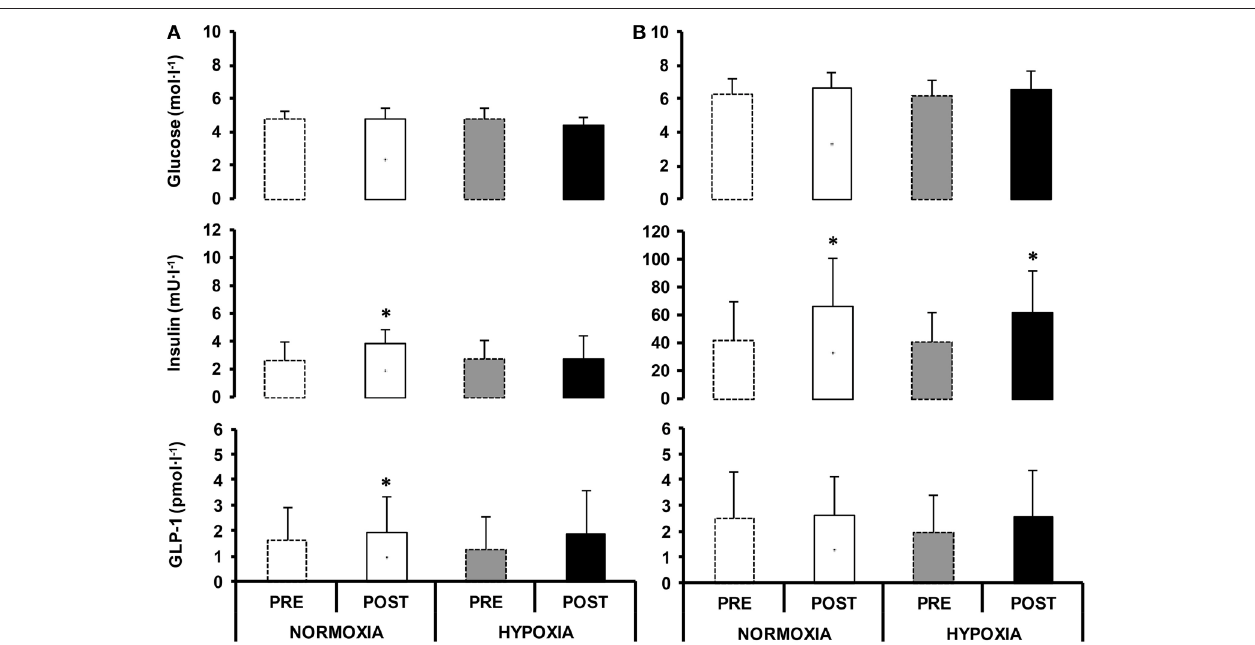
FIGURE 3 | Circulating glucose, serum insulin and GLP-1 values in fasted (A) and postprandial state (mean of 2h, B), before (PRE) and after (POST) 10-day normoxic (NORMOXIA; A) and hypoxic (HYPOXIA; B) confinement. Values are mean ± SEM. *Indicates significant difference between PRE and POST confinement ( p < 0.05